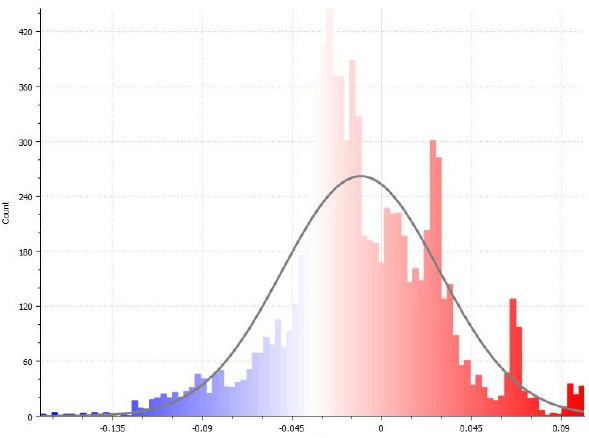
Figure 9. Distribution of residuals for Patch 1 of Wall 4 (x is given in meters).